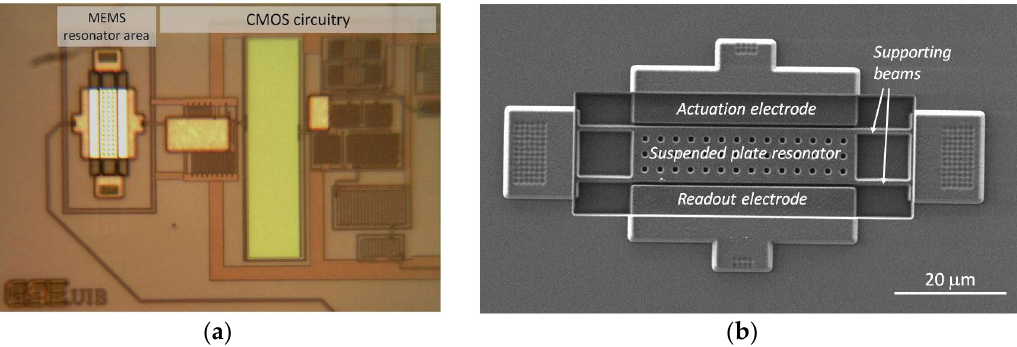
Figure 4. Fabricated device in a complementary metal-oxide-semiconductor (CMOS) 0.35-μm commercial technology constituted by a plate resonator integrated monolithically with CMOS circuitry: ( a ) Optical image of the overall CMOS-MEMS oscillator circuit; ( b ) SEM image of the metal suspended plate resonator.